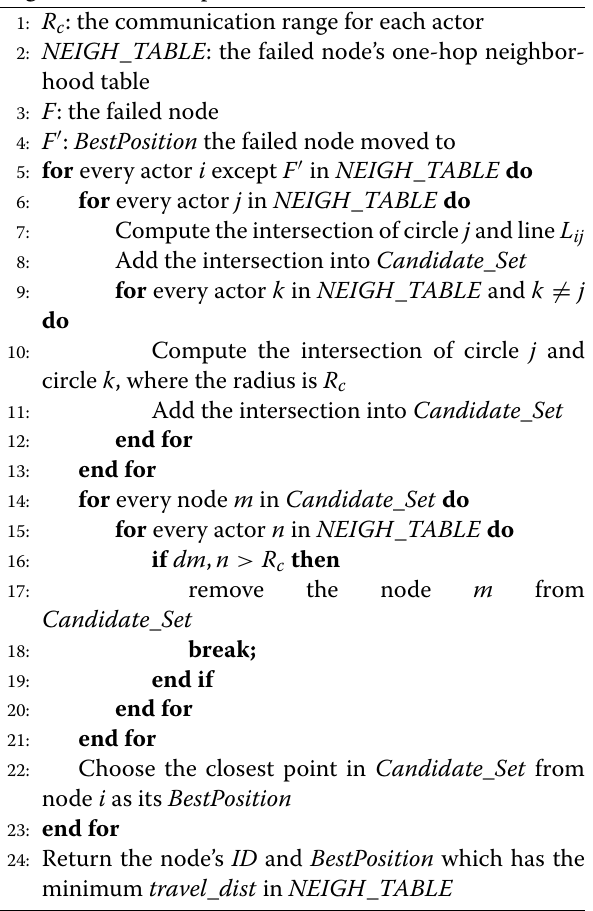
Algorithm 2 Backup Node